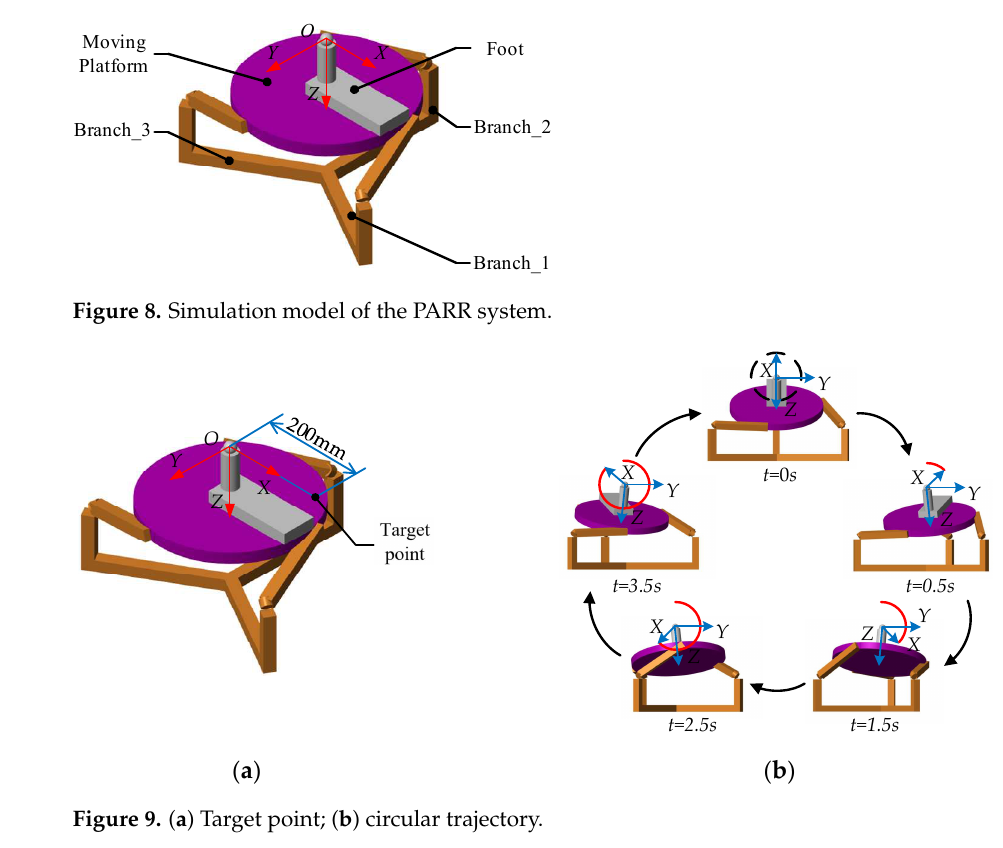
Figure 7. ( a ) Simulation module construction; ( b ) the PARR model; ( c ) the branch simulation.